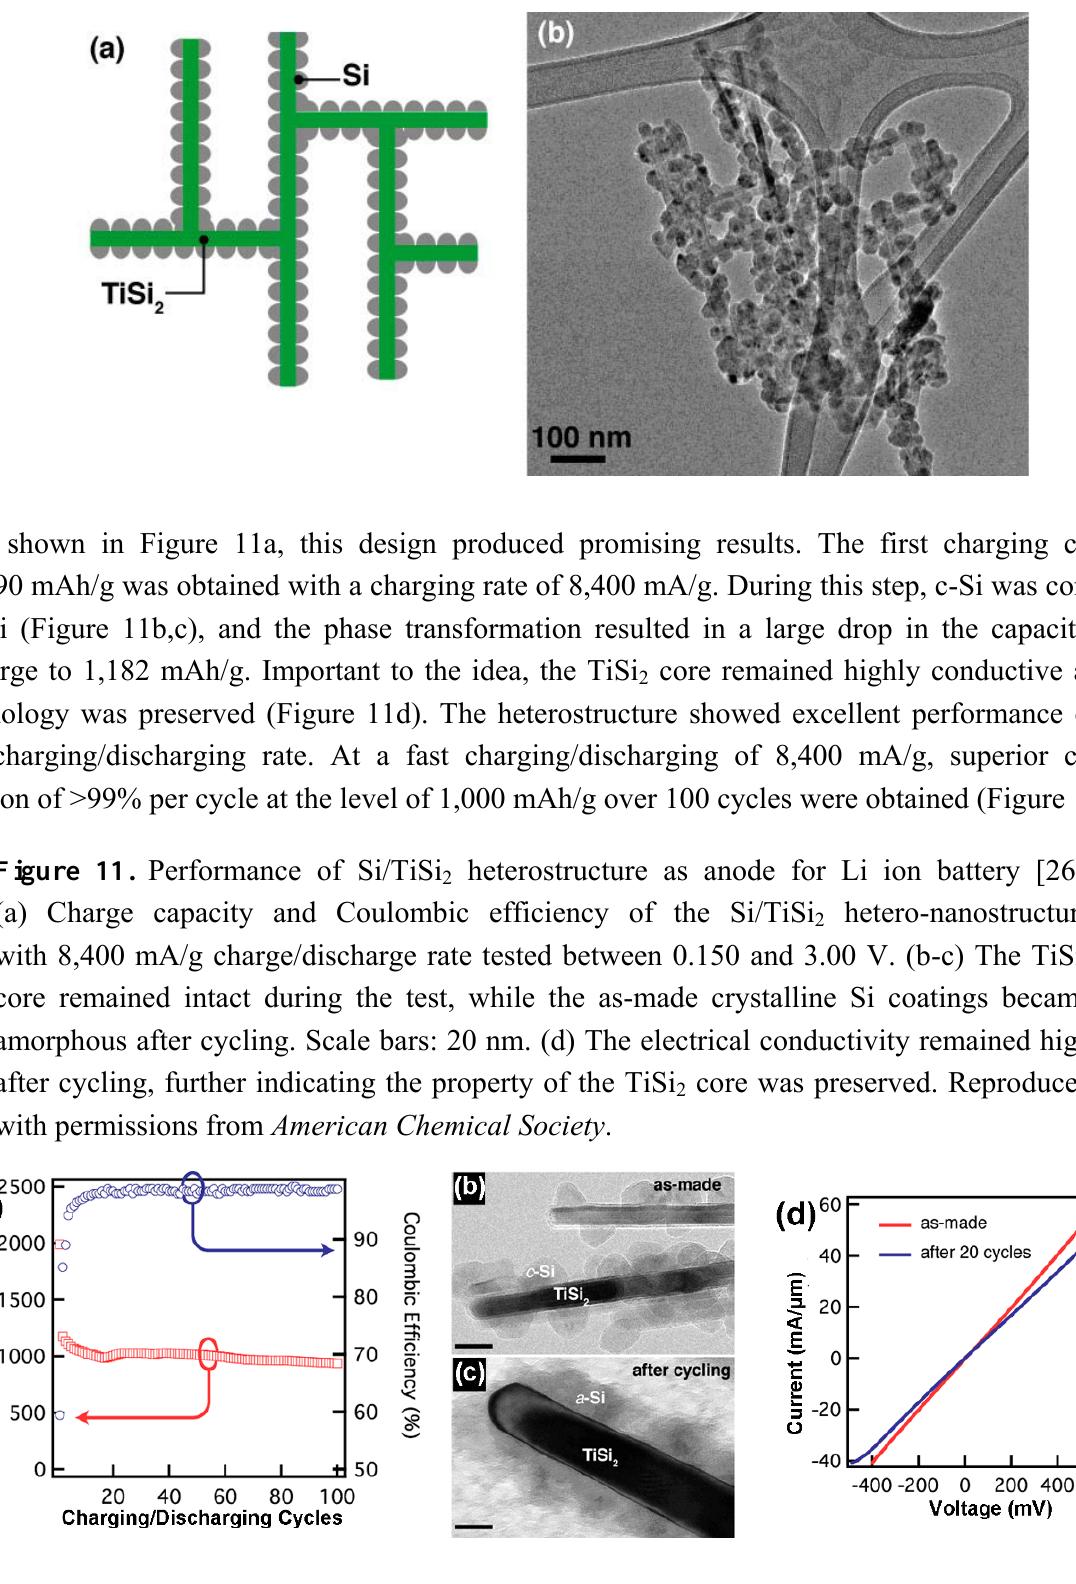
Figure 10. Si/TiSi heterostructure as anode of a lithium ion battery [26]. (a) A schematic 2 illustration of the design. (b) A TEM image showing particulate Si coated on single-crystalline nanonets. Reproduced with permissions from American Chemical Society . TiSi 2